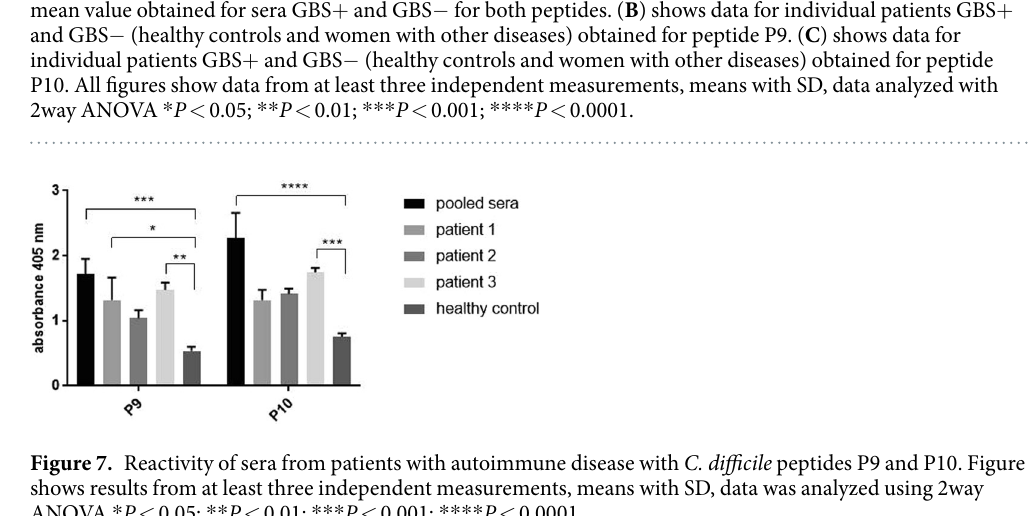
might be possible to prevent decoy effect and protein mutation which are used by bacteria as a strategy of escaping immune response. The search for CD new vaccine antigens was major purpose of these studies. It started with isolation of surface proteins by gentle ‘washing off’ from bacterial cell surface without its damaging. The isolate consists primarily of surface proteins 19 . Clinical strains used for the purpose of protein isolation were collected from patients to take into account currently occurring ribotypes. Western blotting analysis was performed using umbilical cord blood sera from patients without the symptoms of CDI. The use of umbilical blood sera to identify new cross-reactive proteins with other pathogens have been practiced in our Laboratory for years 20,26 . As the transmission of